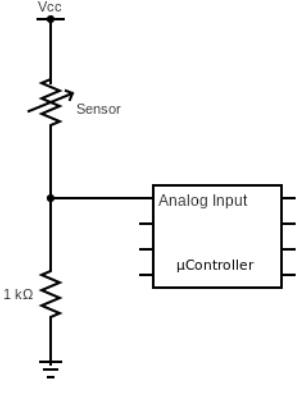
Figure 2. Connection circuit for analog sensors.